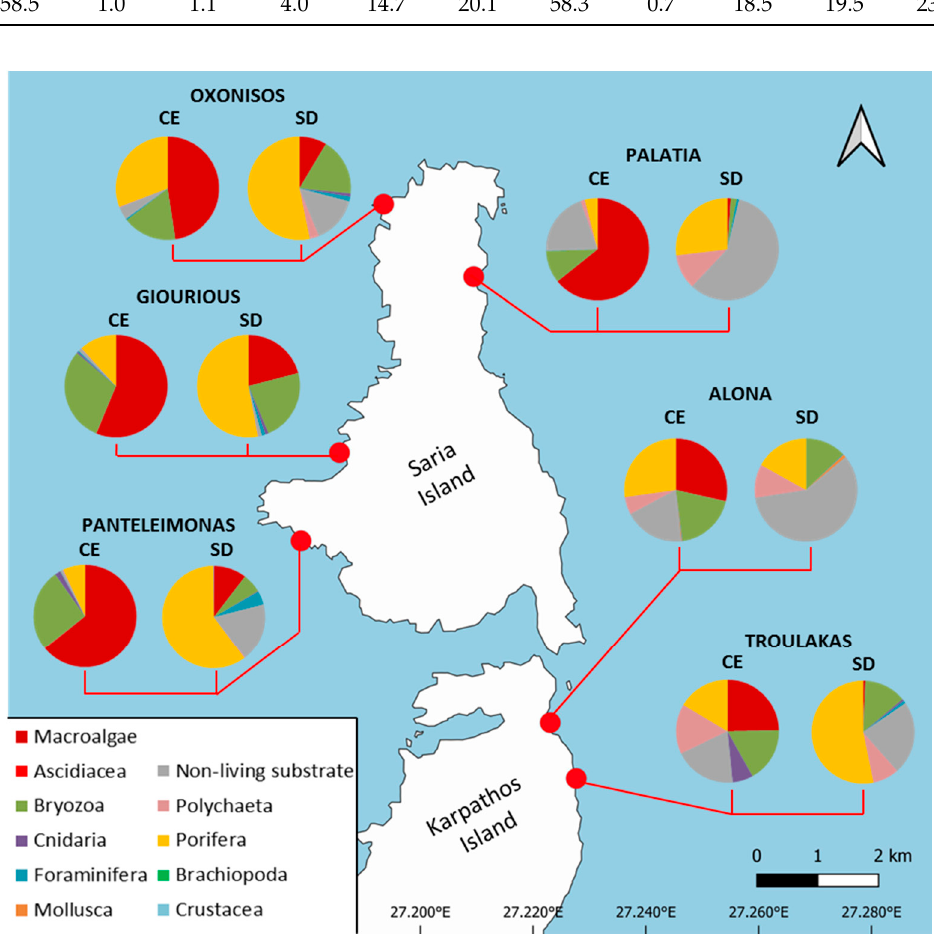
Figure 2. Location of the studied caves and percent of coverage of identified sessile taxa and non- living substrate is presented for each ecological cave zone (CE: cave entrance, SD: semi-dark zone). Table 2. Summary data with the average percentage of coverage (%) of all groups of sessile taxa and non-living substrate for each ecological cave zone. ALO: Alona, GIOU: Giourious, OXO: Oxonisos, PAL: Palatia, PANT: Panteleimonas, TROU: Troulakas, CE: entrance zone, SD: semi-dark zone, NLS: Non-living substrate.